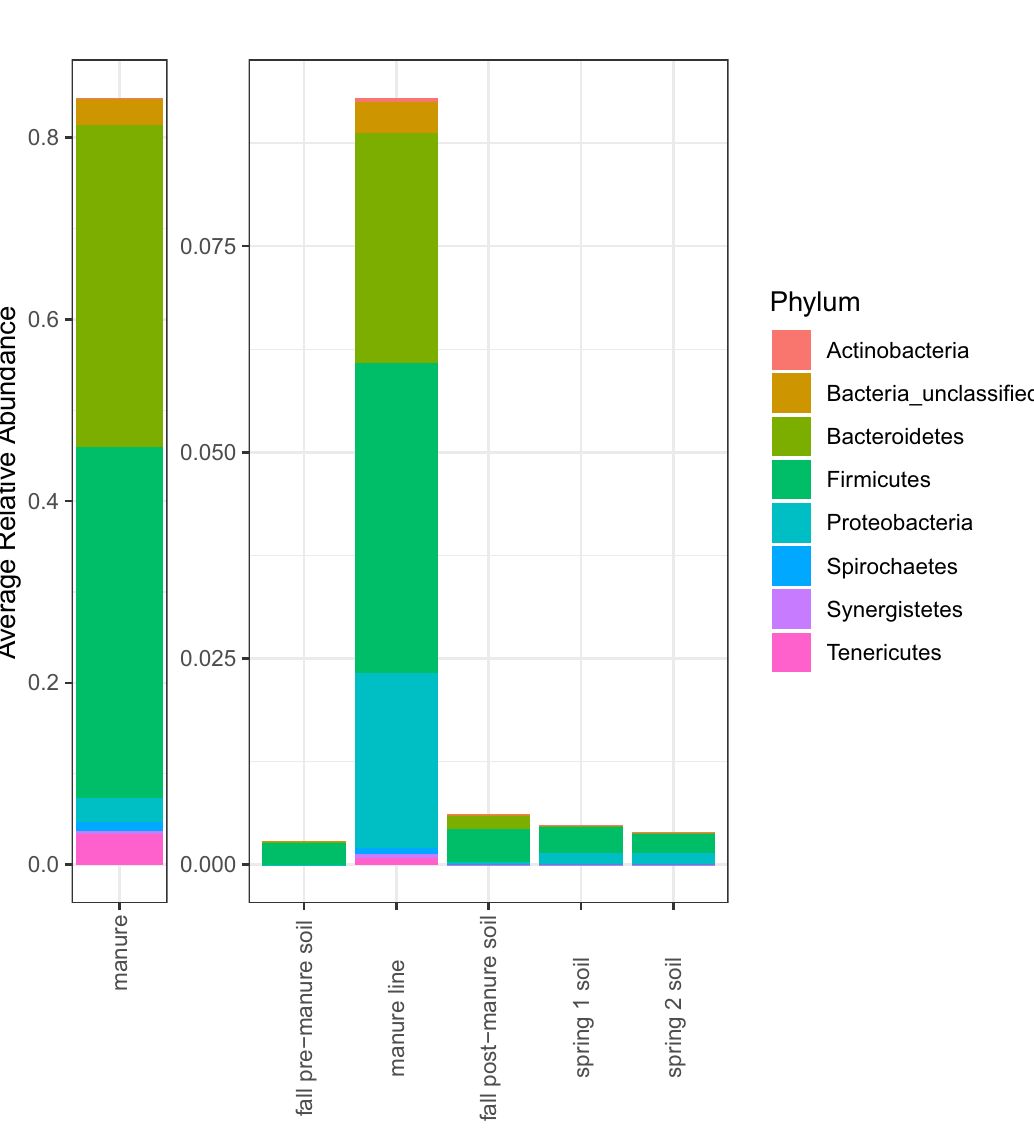
Fig 4. Average relative abundance of manure associated OTUs. OTUs are classified as manure associated if abundances were significantly greater (P < 0.05) in manure compared to fall pre-manure soil.